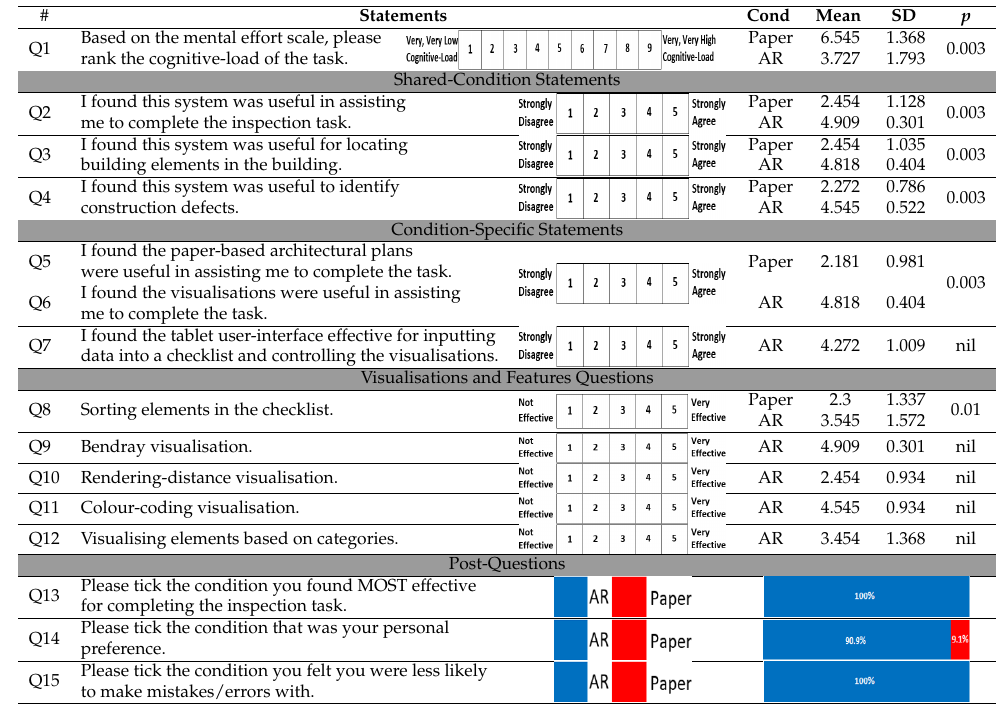
Table 3. Questionnaire results for each condition (paper = paper-based condition; AR = augmented- reality condition). A Wilcoxon Signed rank test was used to determine the significance for each Likert-based question (Blue shading represents AR condition, red represents paper-based